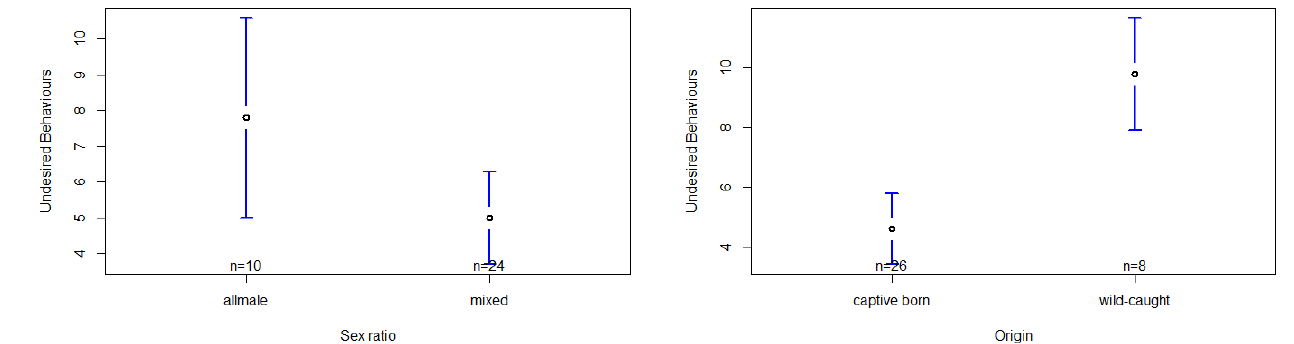
Figure 4. Confidence interval plots of undesired behaviors and the two significant fixed factors (sex ratio, origin).